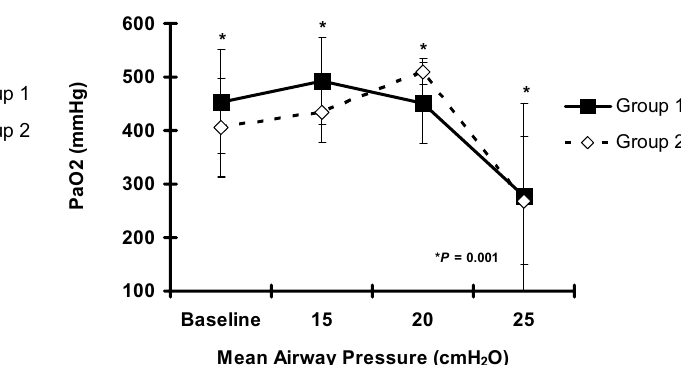
FIGURE 1 - Mean Arterial Blood Pressure: MABP significant lower in MAP 25 cmH O when compared with MAP 15 cmH 2 cmH O ( P =0.001) 2